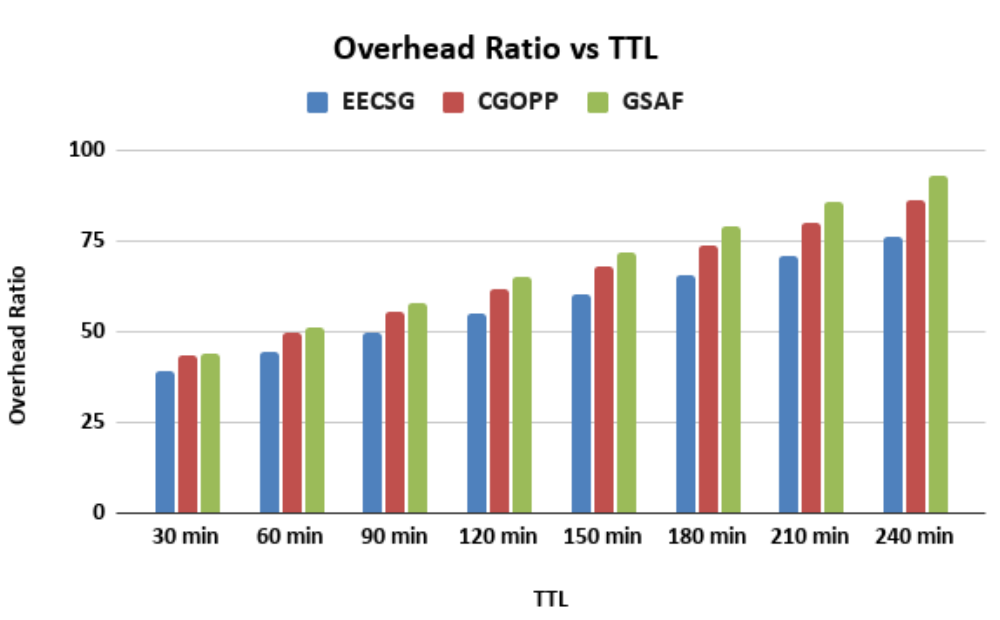
Figure 18. Overhead ratio vs. TTL using real data mobility